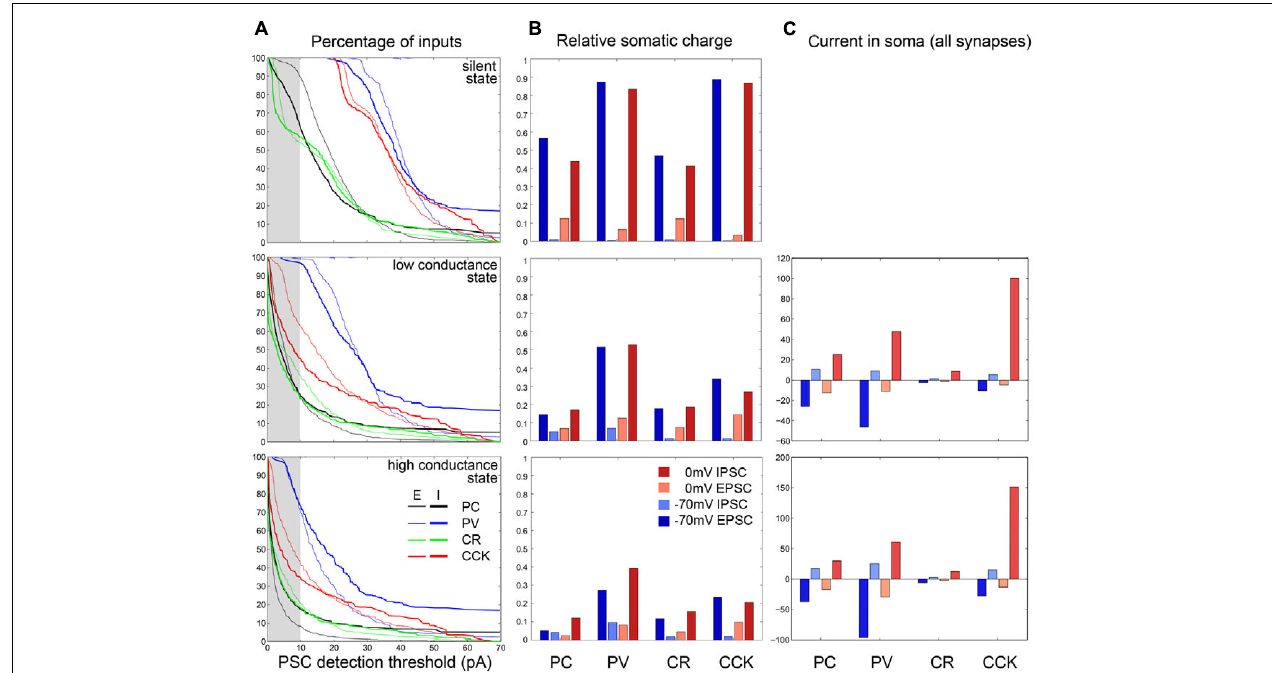
FIGURE 7 | Quantification of VC errors at different activity levels for the four examined cell types. (A) The left column plots at three activity levels (first row: SS; second row: LCS; third row: HCS) for the four examined cell types (PC black, PV blue; CCK red; CR green) the cumulative amplitude curve for EPSCs (thin) and IPSCs (thick). The attenuation is strongest for PC and CR cells, weakest for PV cells. Note that as background activity and thus conductance increases, the curves shift to the left and more events disappear in the gray bar representing the 10 pA PSC detection threshold. (B) The average charge attenuation of excitatory and inhibitory inputs recorded at − 70 and 0 mV, and weighted by synapse density (see Materials and Methods) are shown at different activity levels for the four cell types. In the non-realistic silent case excitatory and inhibitory events can be recovered reasonably well, though IPSC charge is contaminated by the relatively large amount of badly clamped EPSCs. In the more active cases, the attenuation is very strong for all cells (weakest for PV neurons). The same data are presented numerically in Table 3 . (C) The right column shows the average excitatory and inhibitory current at the soma at − 70 and 0 mV for the four cells, taking into account the synaptic densities and the estimated activation frequencies for these synapses in the active states. (The analogous plot is not shown for the SS where the average synaptic currents are zero due to the absence of presynaptic